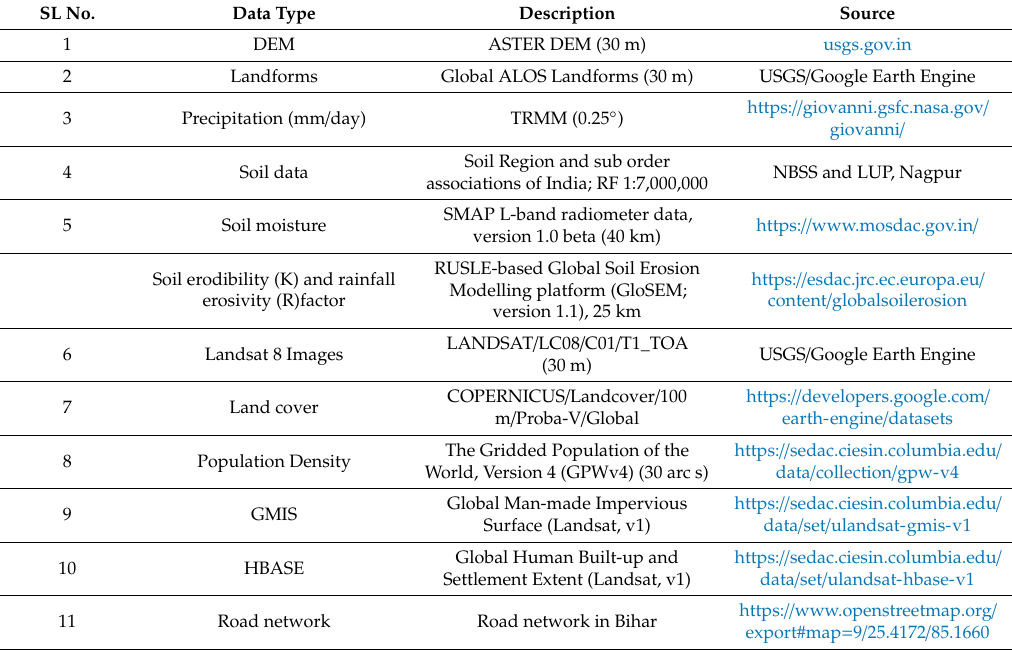
Table 2. Description of data sources used for processing flood conditioning criteria. SL